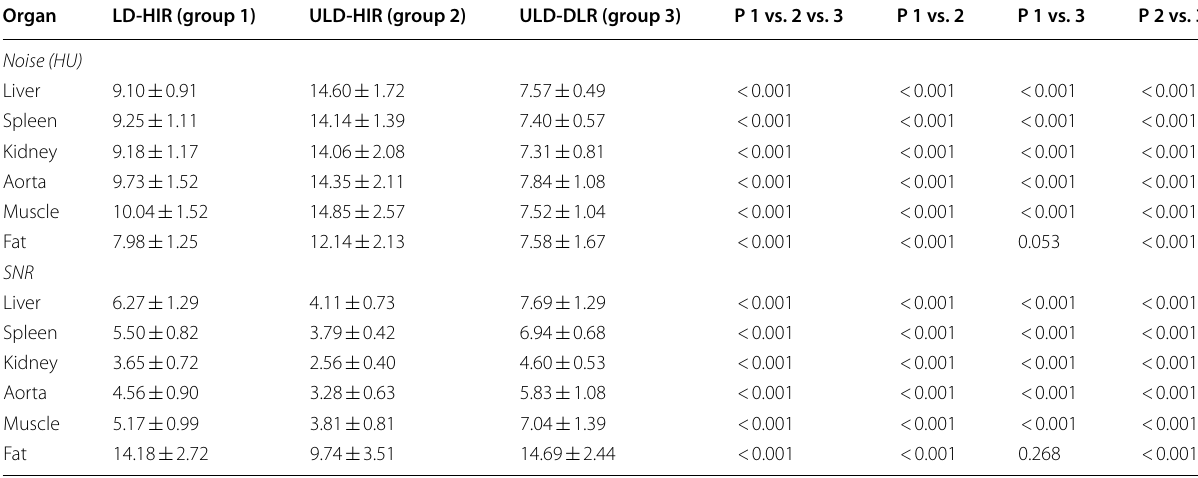
Table 3 Noise and signal-to-noise ratios (SNRs) for various abdominal organs and tissues Organ